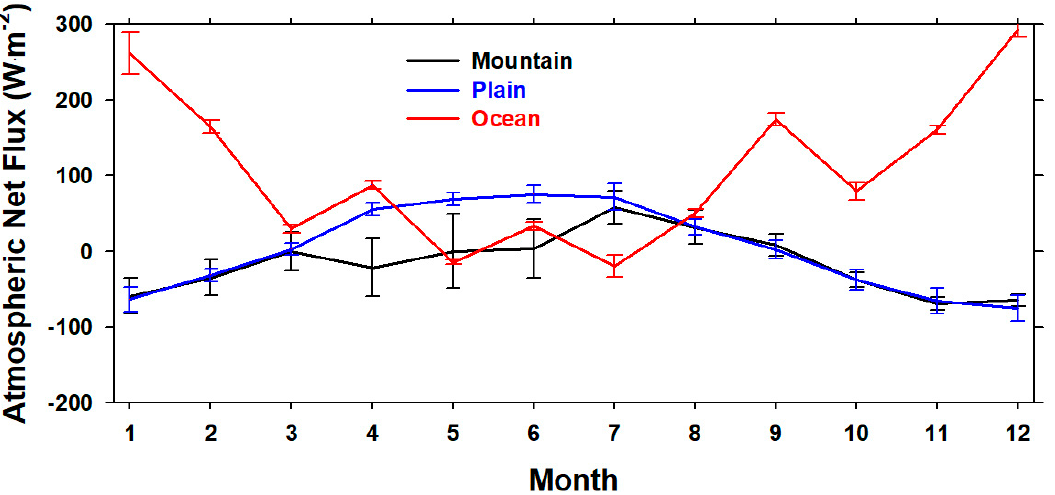
Figure 8. Variations in monthly mean atmosphere net flux (NF_Atm) in 2021 over mountain, plain, and ocean regions (the vertical bars in this figure, represented the standard deviation, but their values were too small. So, they were drawn by magnifying them ten times).